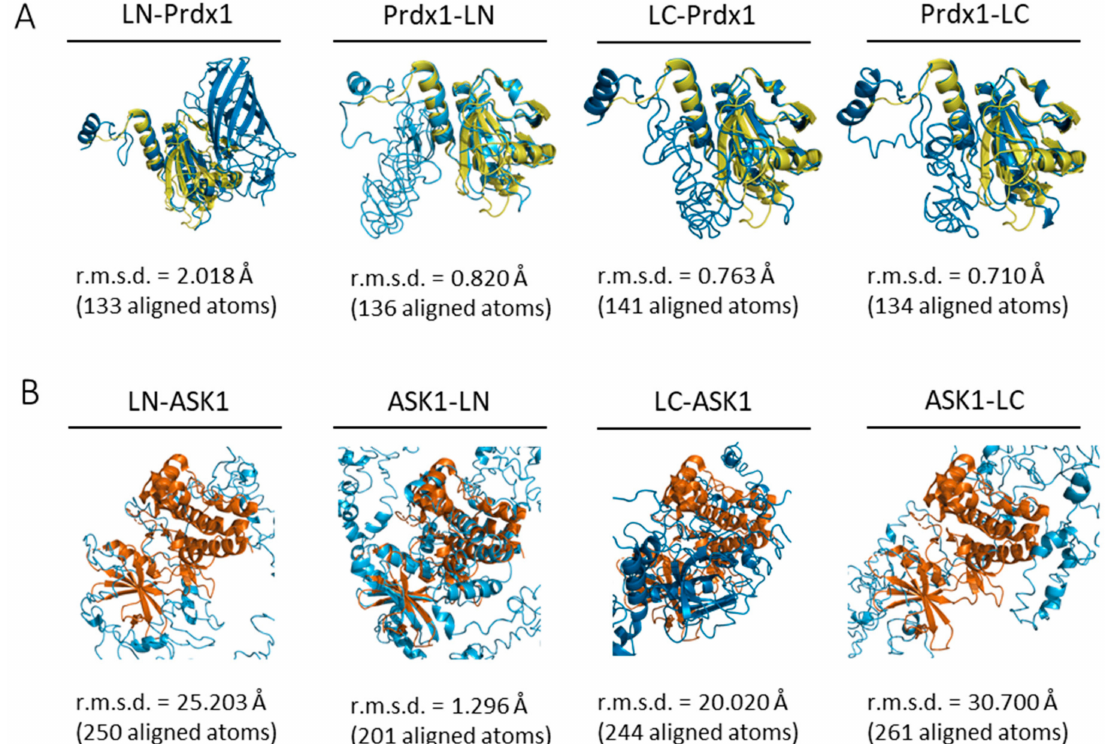
Figure 2. All ab initio Prdx1-mLumin models and the ASK1-LN model maintain the structural fold of Prdx1 and ASK1. Prdx1- and ASK1-mLumin ab initio models were superimposed with the human Prdx1 C83S mutant (PDB ID: 4XCS) andthe human ASK1 kinase domain (PDB ID: 2CLQ). ( A ) All Prdx1-mLumin ab initio models (blue) showed a low r.m.s.d. value with human Prdx1 C83S mutant (PDB: 4XCS) (yellow). ( B ) Only the ASK1-LN ab initio model (blue) showed a superimposition with a relatively low r.m.s.d. value with human ASK1 kinase domain (PDB ID: 2CLQ) (orange). The r.m.s.d. value is displayed for each superimposition. Superimpositions were done in PyMol (Version 2.4.1, Schrödinger, Inc., New York, USA) [40]. LN: large N-terminal half of mLumin. LC: small C-terminal half of mLumin.